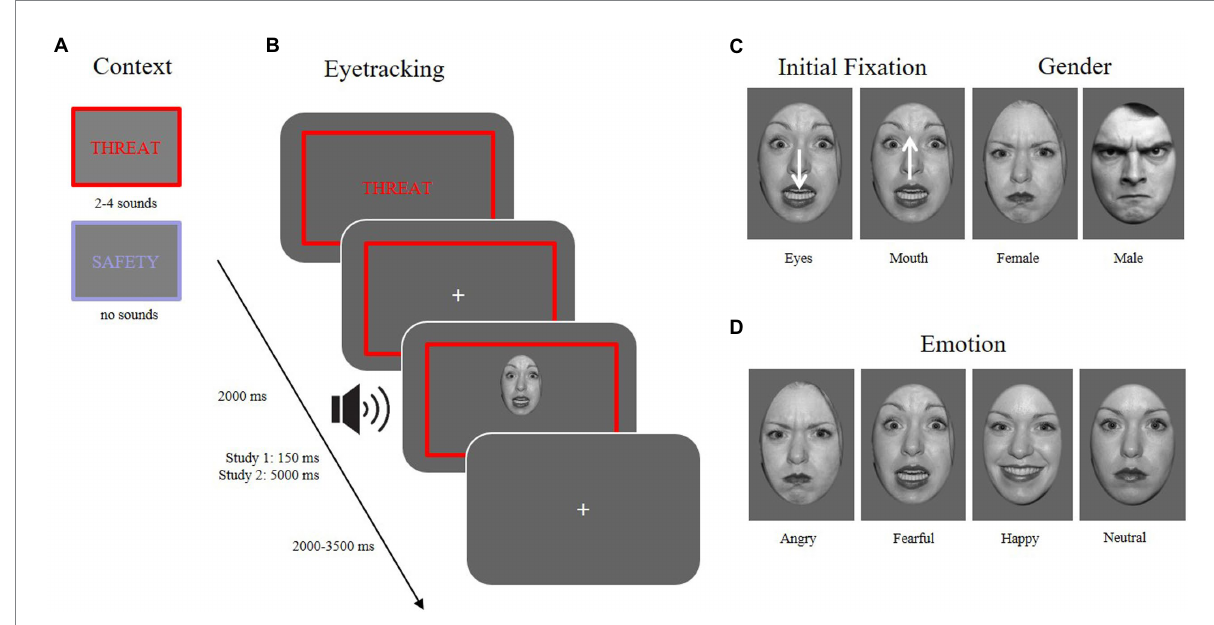
FIGURE 1 Different conditions of the experimental paradigm. (A) Context : two possible context manipulations (threat vs. safety). (B) Eyetracking : an example trial sequence in the threaten context with an aversive sound playing at the onset of a facial expression (~13–27% contingency) while measuring eye movements. (C) Initial fixation : the face is presented either with the mouth at the location of the previously attended fixation cross, or the face was shifted downward, so that the eyes were presented at the location of the fixation cross. Gender : 50% of the presented stimuli were male, 50% female faces. (D) Emotion : Stimuli used in the experiment (and depicted here) were taken from the NimStim database (Tottenham et al., 2009) and included four emotional expressions (angry, fearful, happy,